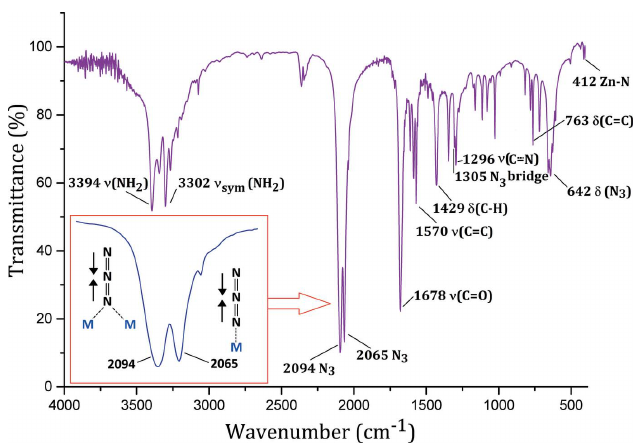
Figure 2 IR spectrum (KBr pellet) of the title complex, with assignment of the main bands. The inset is an expansion of the antisymmetric stretching vibrations for azide